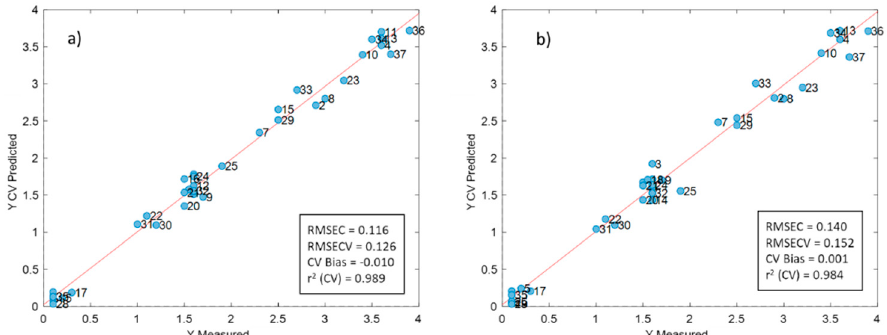
Figure 9. Results of the low-( a ) and mid-( b ) level data fusion models for the prediction of fats.